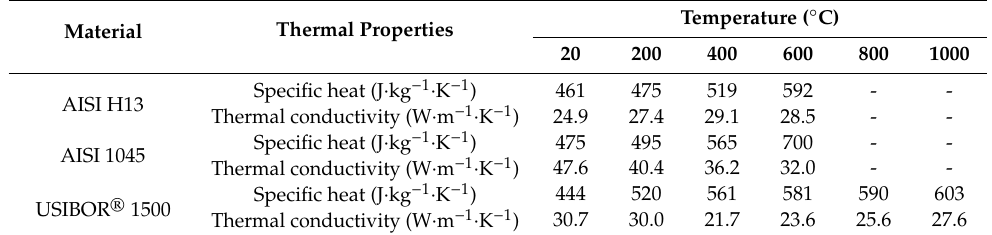
Table 4. Thermal properties of AISI H13, AISI 1045, and USIBOR 1500, data obtained from [21,22,30].